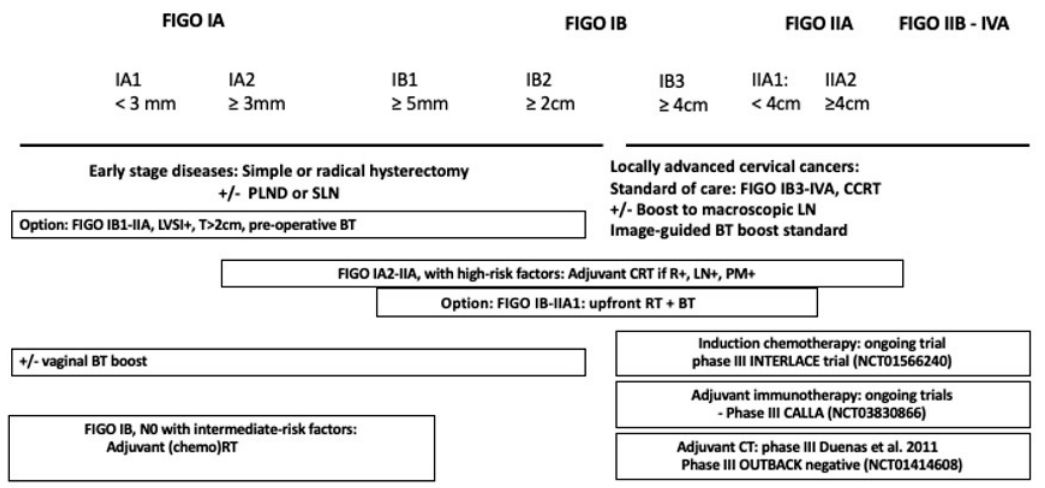
Figure 1. Treatment algorithm for cervical cancers according to FIGO 2018 classification [22,24,26–29, 31,32,43–45,52–58,60–65,67–72,91]. FIGO, F é deration Internationale de Gyn é cologie et d’Obst é trique; PLND, pelvic lymph node dissection; SLN, sentinel lymph node; LN, lymph node; CCRT, concurrent chemoradiotherapy; RT, radiotherapy; BT, brachytheraph; LVSI, lymphovascular space invasion; DSI, Deep stromal invasion.